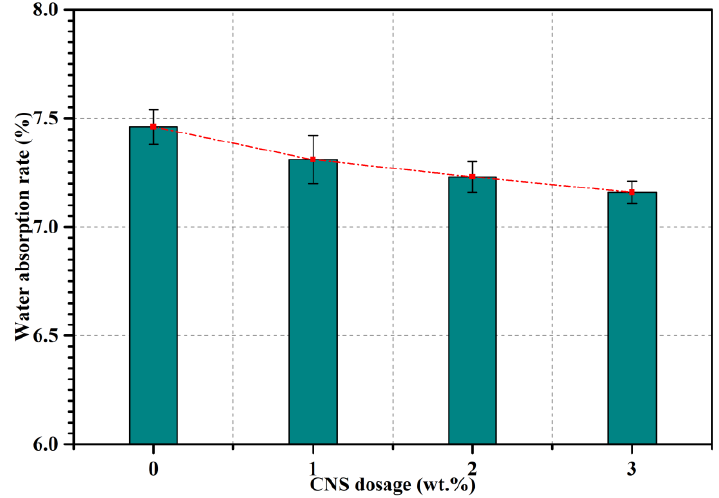
Figure 6. Water absorption of